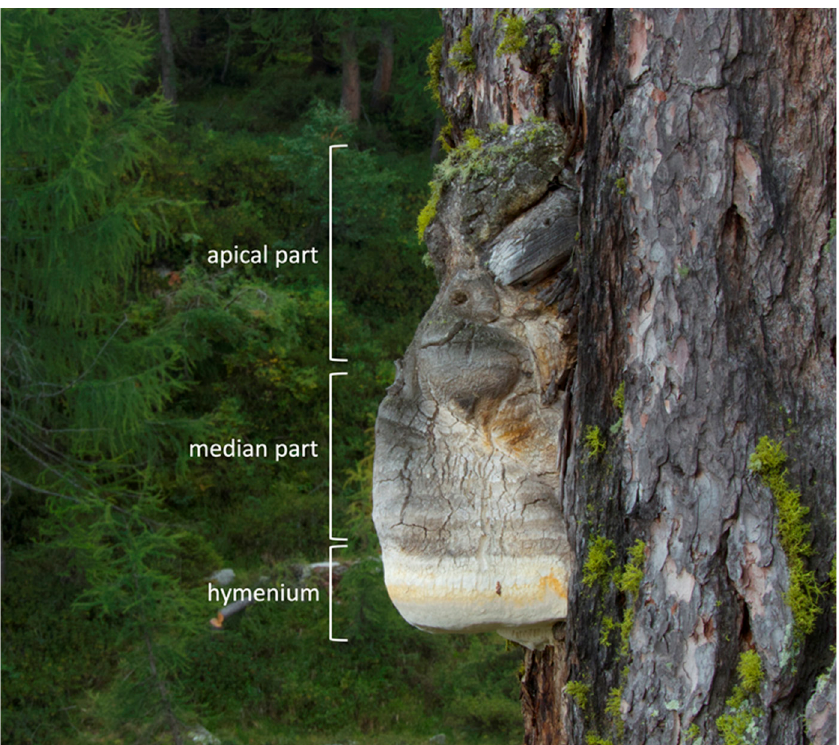
Figure 4. F. officinalis mushroom with the three investigated parts .